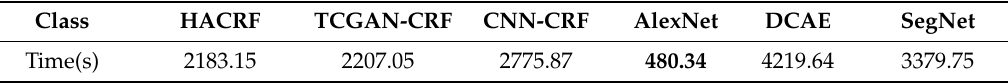
Table 5. Comparison of run time (seconds) with five state-of-the-art